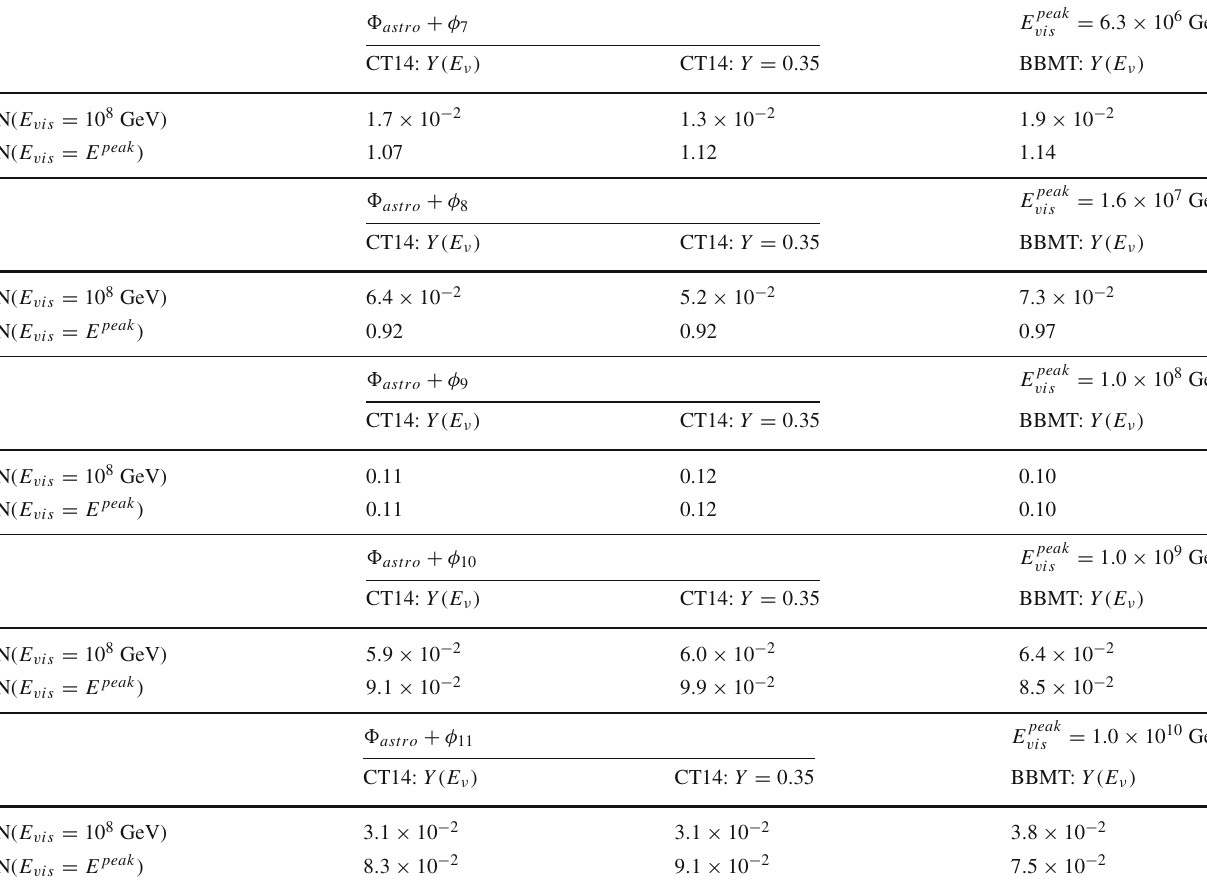
Table 1 The number of events in the IceCube detector for 6 years of the detector exposure, for the models and fluxes consider. In all cases, the normalization for the Super-Glashow fluxes, φ 0 j , were adjusted to generate ≈ 1 neutrino event at the energies above the Glashow resonance (cid:6) + φ astro